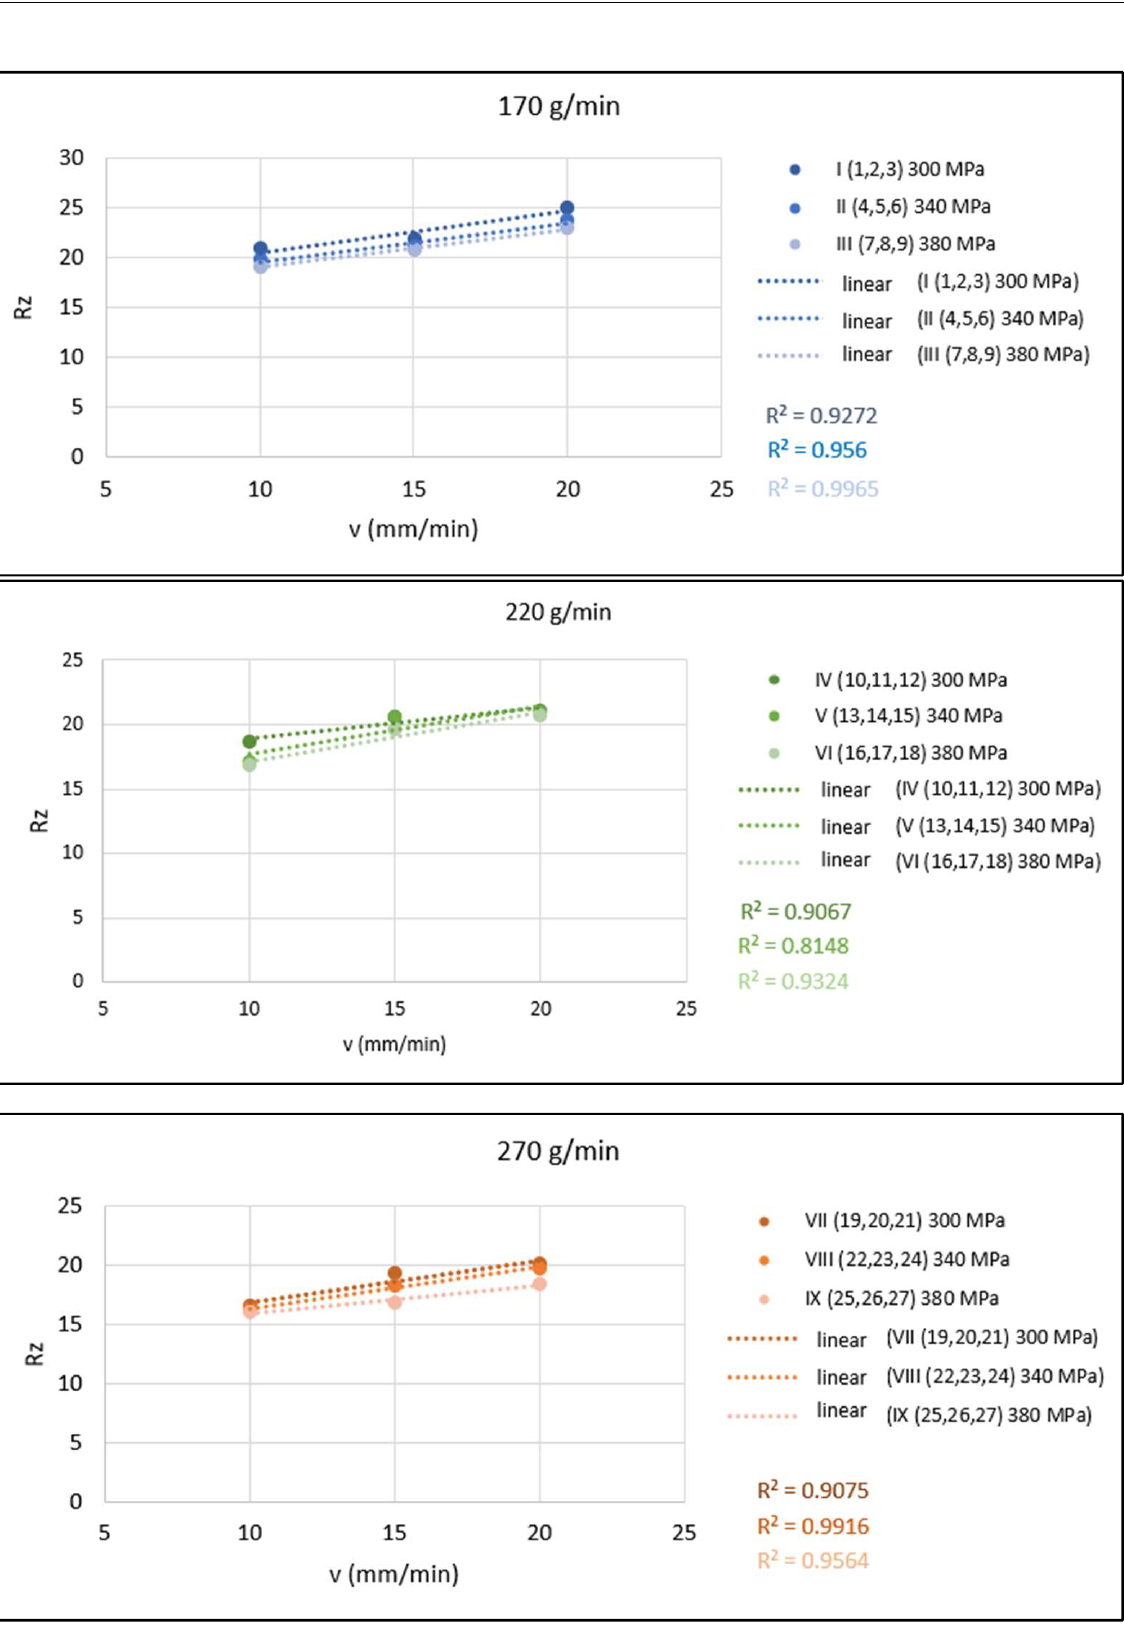
Figure 7. Graphical evaluation of 1-parametric dependencies of Rz = f( v ) for m A = 170, 220 and 270 g/min.